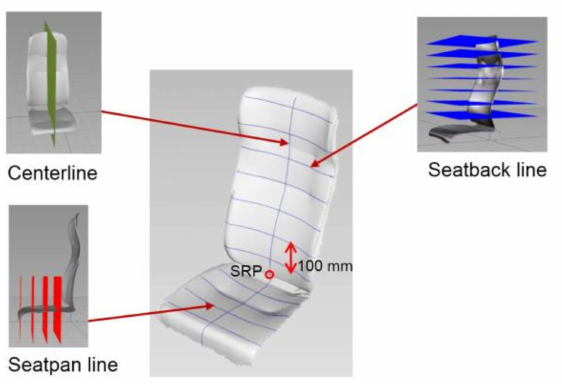
Figure 4. Critical cross-sections and outlines of a bus seat profile.